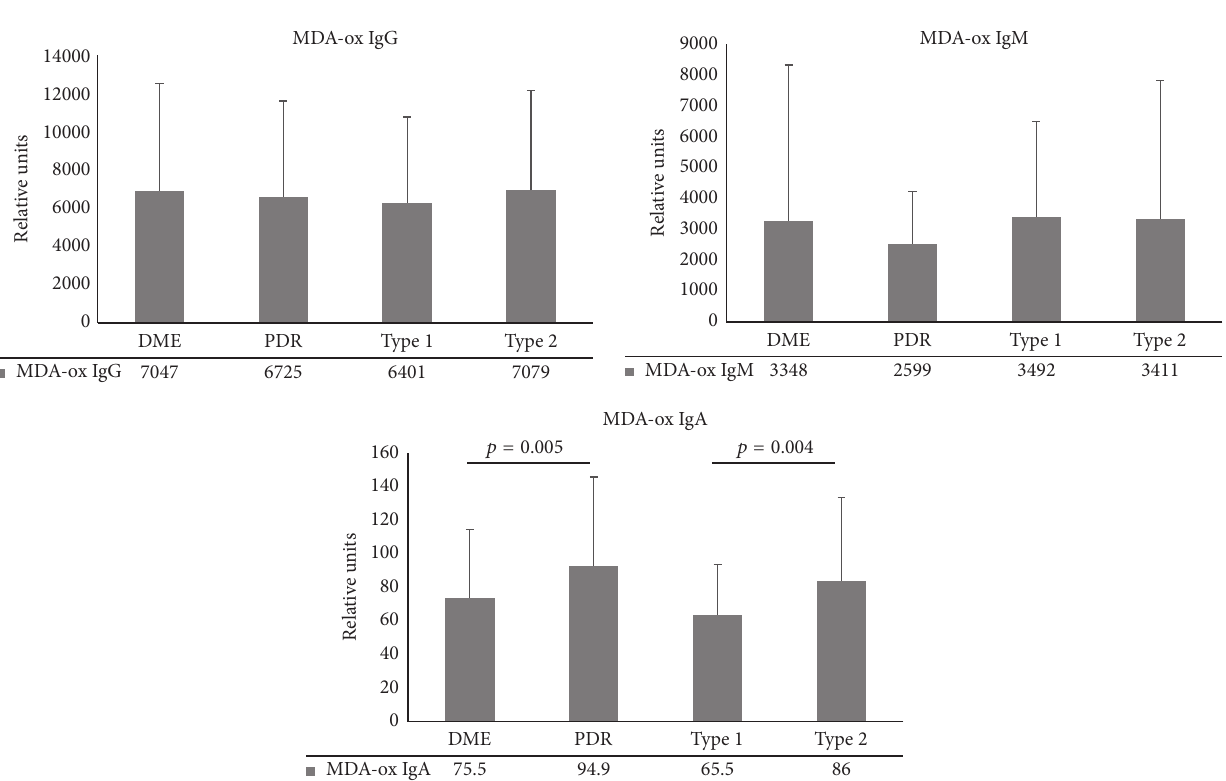
Figure 2: Autoantibody levels against MDA-oxLDL (MDA-Ox IgG, MDA-Ox IgM, and MDA-Ox IgA) in macular edema patients (DME), proliferative retinopathy (PDR), and type 1 and type 2 diabetes patients. The levels are expressed as mean relative units and standard deviation.